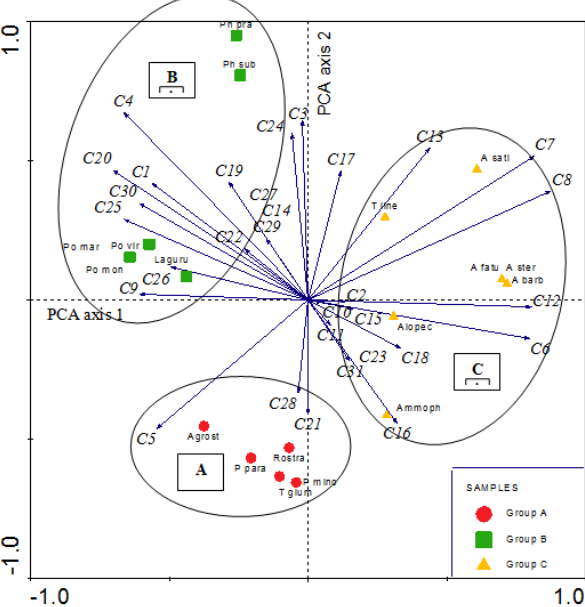
Fig. 2. Principal component analysis (PCA) of the studied spe- cies of Aveneae based on 31 morphological characters (arrows), together with their clusters (A, B and C). See Tab. 2 for abbre- viations of species, and Tab. 3 for character